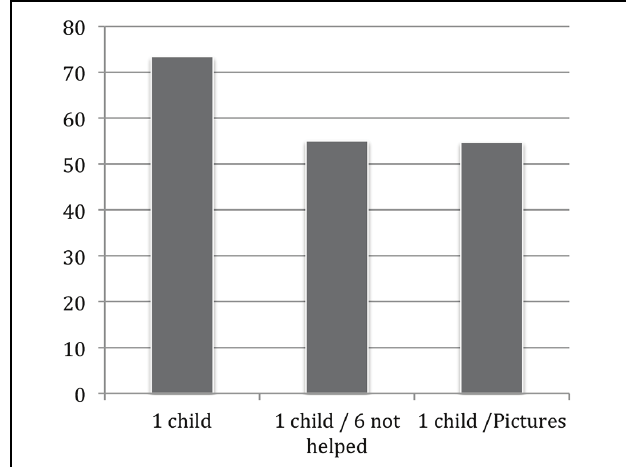
FIGURE 6 | Mean warm-glow ratings in the picture study (Study